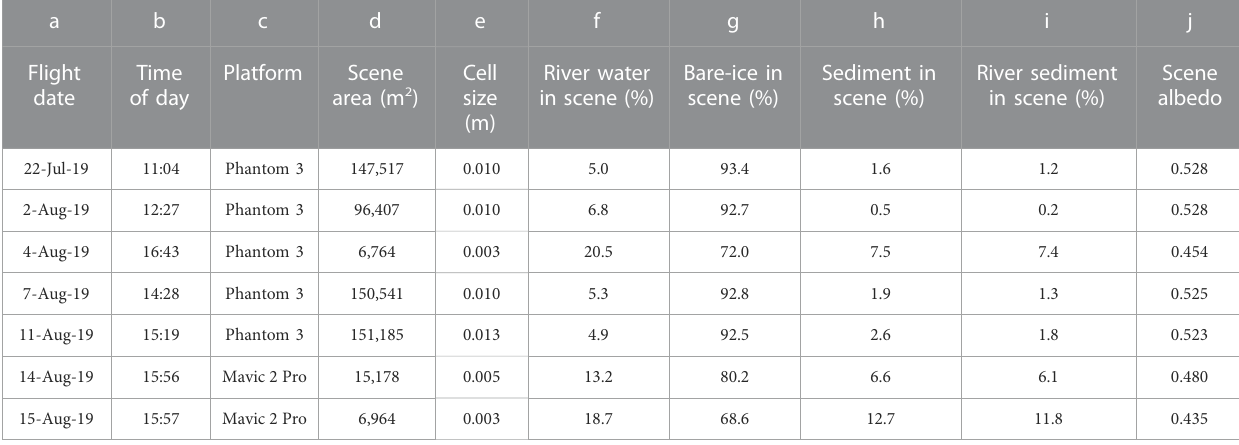
TABLE 1 Statistics of the spatial distribution of sediment and water within each fl ight scene including the date (a) and average time the images were collected (West Greenland local time) (b), UAV platform (c), area of the UAV scene footprint (d), structure-from-motion output cell size (e), the percent of the scene covered by river water rivers (includes both river beds covered by sediment and clear ice) (f), the percent of the scene covered by bare ice (g), the percent of the scene